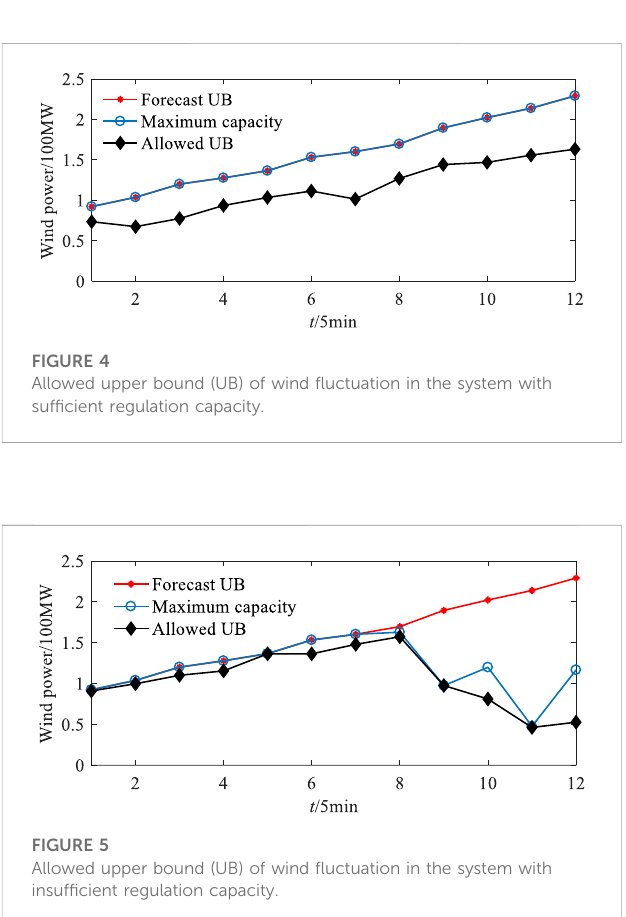
FIGURE 5 Allowed upper bound (UB) of wind fl uctuation in the system with insuf fi cient regulation